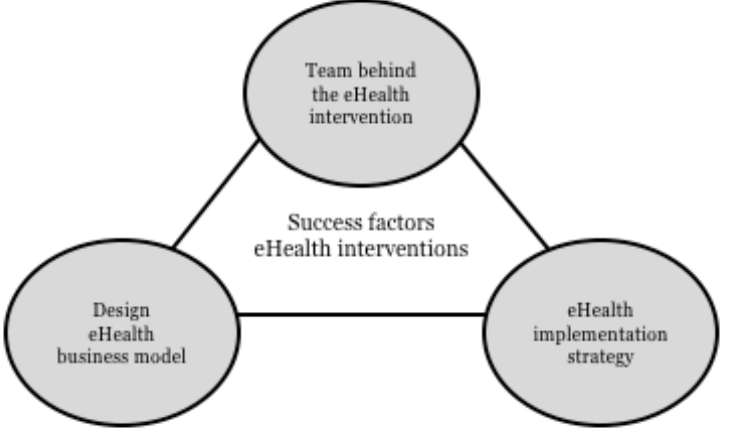
Figure 3. Success factors of the eHealth interventions for caregivers of people with